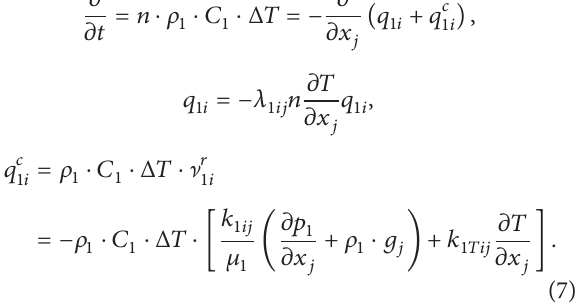
Figure 14: Ordinary damage states under triaxial stress.